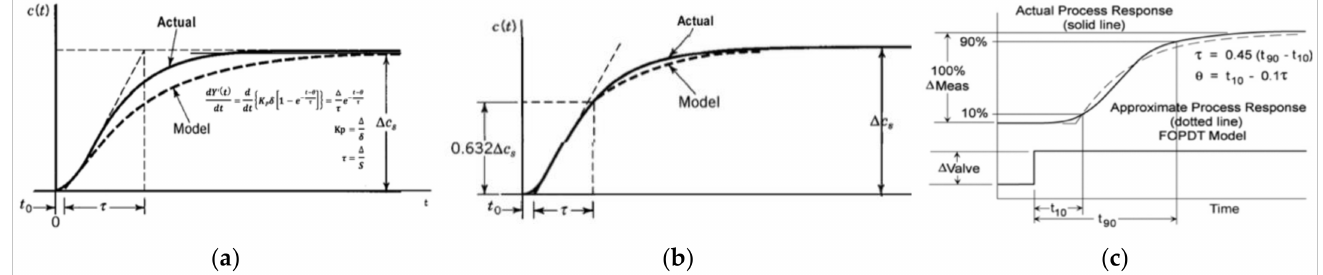
Figure 2. Process reaction curve (PRC) of ( a ) Method I, ( b ) Method II, and ( c ) Method III (Source: Smith, 1972; Wade, 2004).